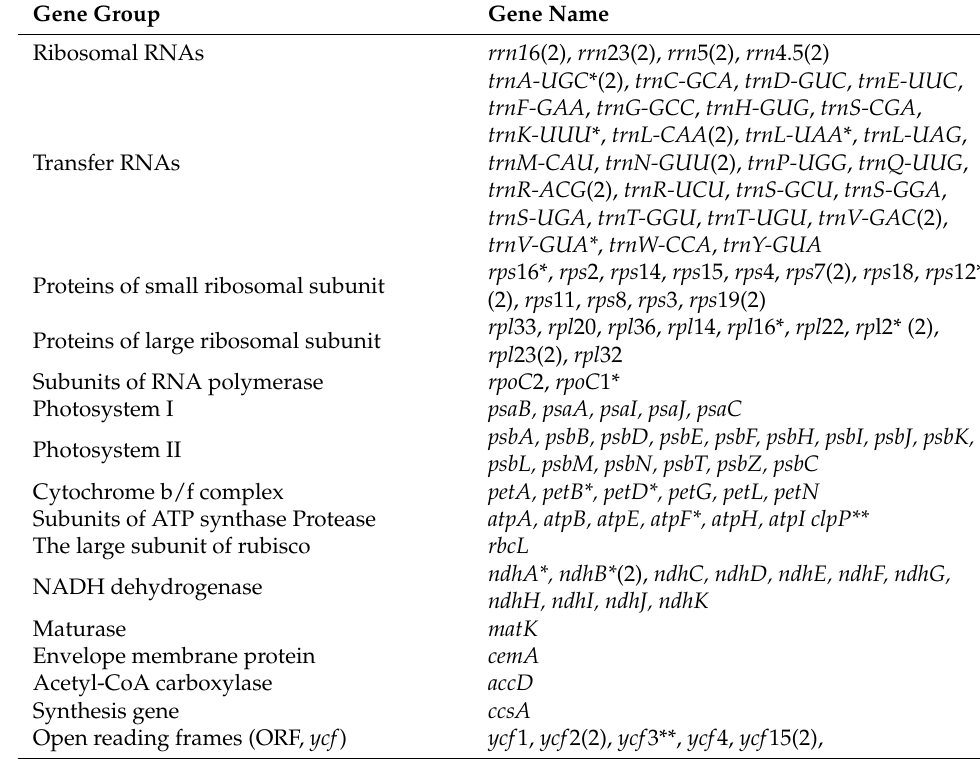
Table 1. List of annotated genes of T. asiatica . Gene Group